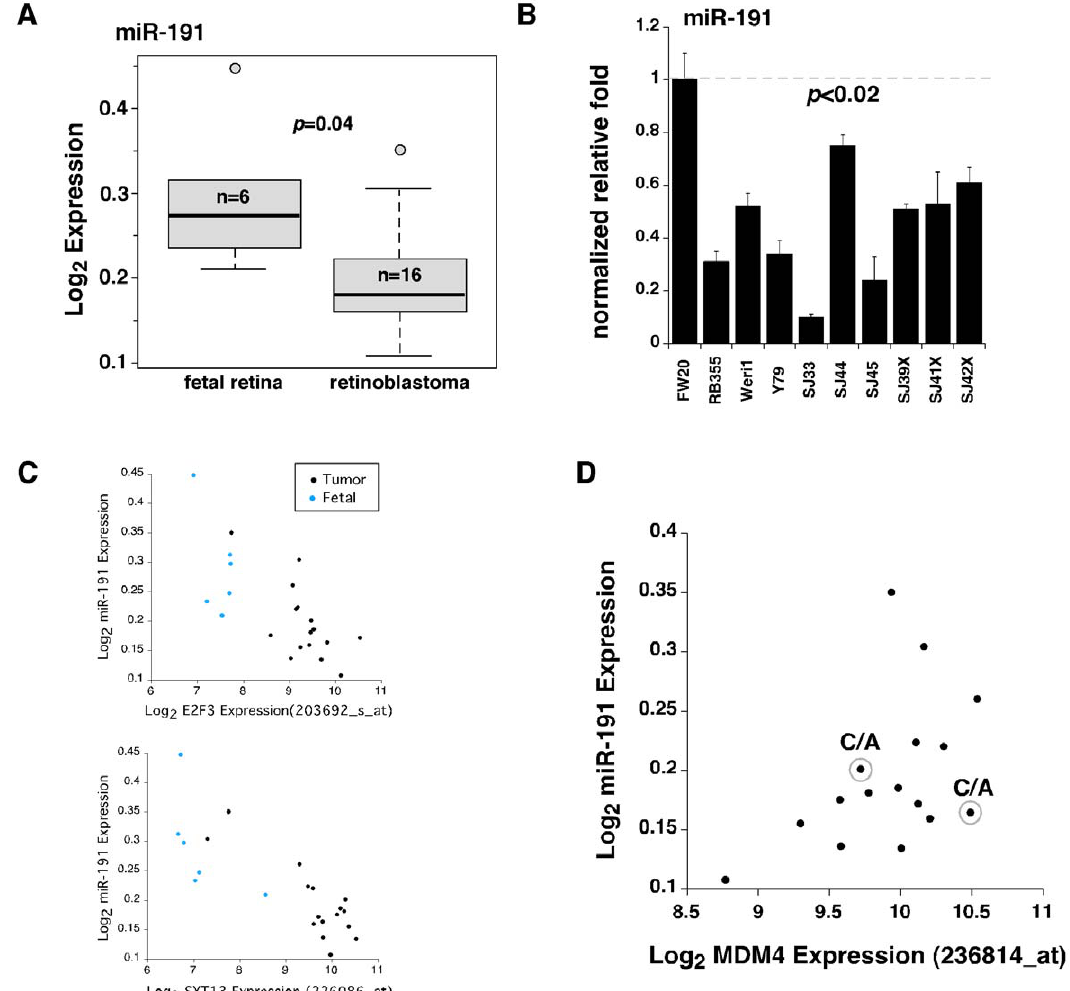
Figure 4. Analysis of miR-191 in retinoblastoma. A ) Boxplot of the Log 2 expression for hsa-mir-191 probeset in 6 fetal retina and 16 primary human retinoblastomas showing significantly lower expression. ( B ) MicroRNA real time-RT-PCR for hsa-mir-191 in fetal retina at gestational week 20, retinoblastoma cell lines (Rb355, Y79, and Weri1), retinoblastoma primary tumors, and orthotopic xenografts. Values are normalized to fetal retina. ( C ) Scatter plots of the Log 2 expression values for hsa-mir-191 and 4 of the representative 44 mir-191 target genes in fetal retina and retinoblastoma primary tumors. Affymetrix probeset in parenthesis. ( D ) Scatter plot of the Log 2 expression values for hsa-mir-191 and MDM4 (Affymetrix probeset 236814_at) in retinoblastoma primary tumors. Circled are primary tumors with a C/A